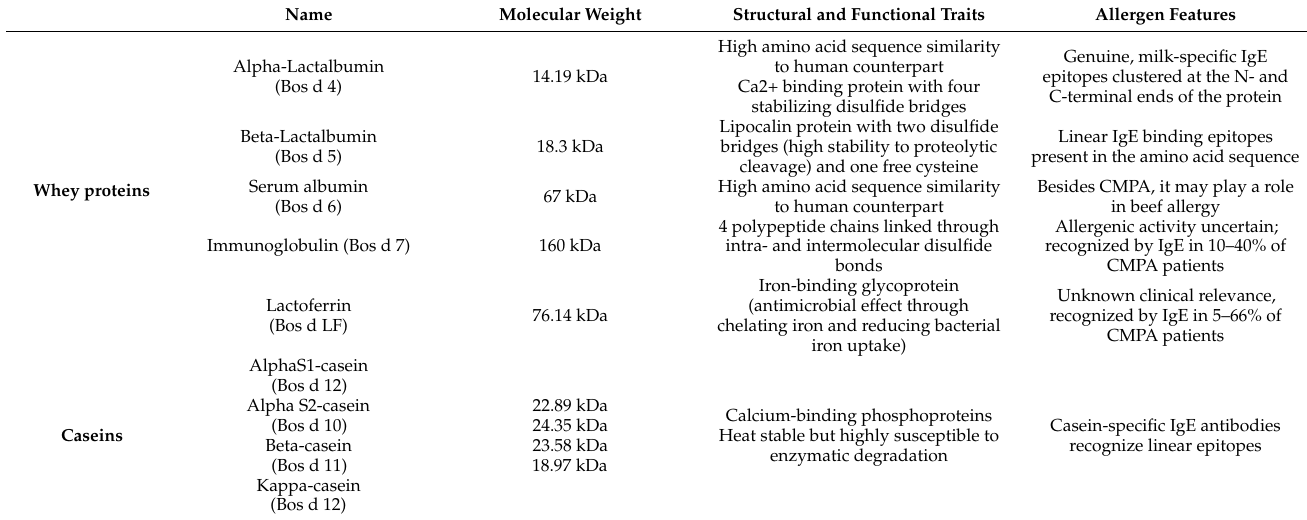
Table 2. Brief summary of the characteristics of main cow’s milk allergens (adapted from Linhart et al.